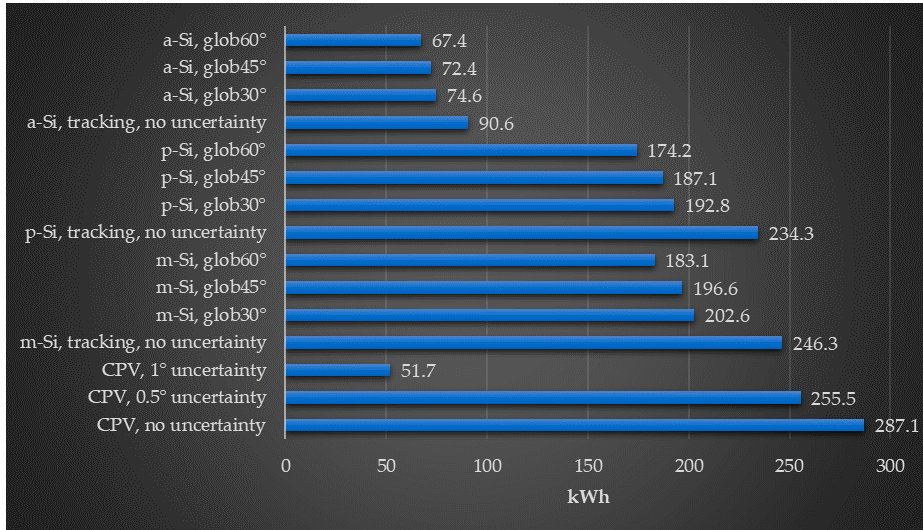
Figure 13. The yearly yields calculated for 2018 for 4 different technologies (CPV, a-SI, m-Si, and p-Si). The results are shown for sun tracking systems (CPV, a-SI track, m-Si track, and p-Si track) and for fixed PV modules with inclinations of 30 degrees (a-Si 30°, m-Si 30°, and p-Si 30°) of 45 degrees (a-Si 45°, m-Si 45°, and p-Si 45°) and 60 degrees (a-Si 60°, m-Si 60° and p-Si 60°). In addition, the yields of a CPV module mounted on a sun tracker with a 0.5° tracking uncertainty (CPV 0.5° uncert.) and with a 1° tracking uncertainty (CPV 1° uncert.) are shown.